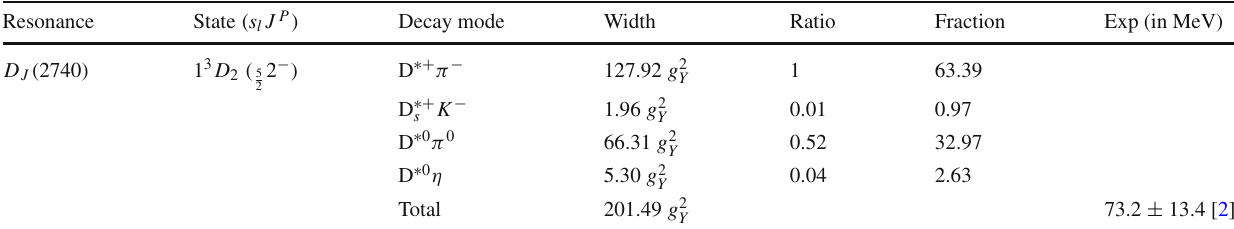
(cid:21)( D ∗ ( 2460 ) 0 → D + π − ) 2 (cid:21)( D ∗ ( 2460 ) 0 → D ∗+ π − ) from various experi- 2